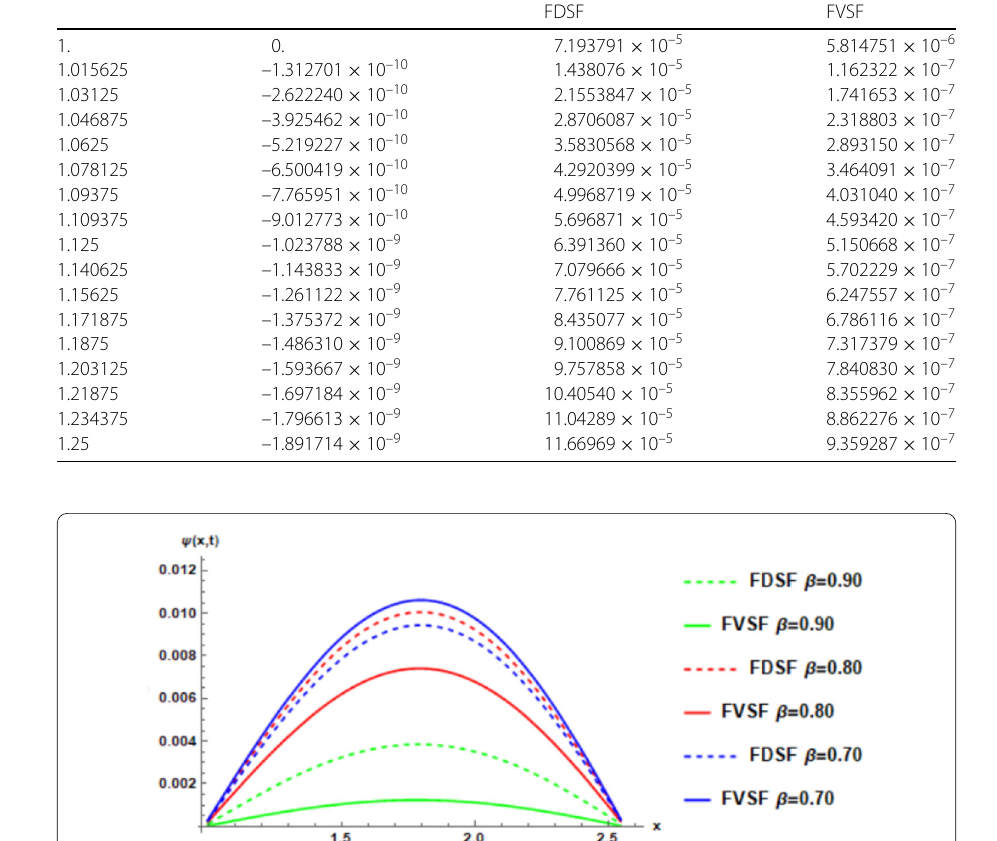
Figure 1 Solutions to Example 1 at time t = 1 for varying β using FDSF and FVSF